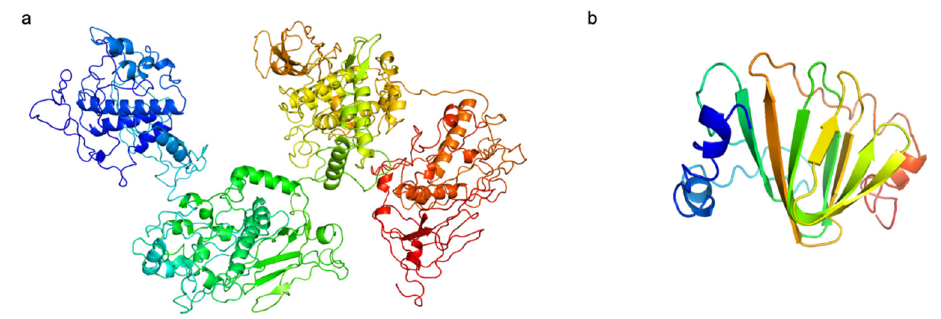
Figure 4. The predicted structures of putative receptor binding proteins in vB_AmeP-R8W (R8W). ( a ) Gp45, putative long tail fibers. ( b ) Gp34, putative short tail fibers. N-terminal is colored blue, and C-terminal is colored red. The C-score of two proterins are − 1.85 and − 0.86, respectively.